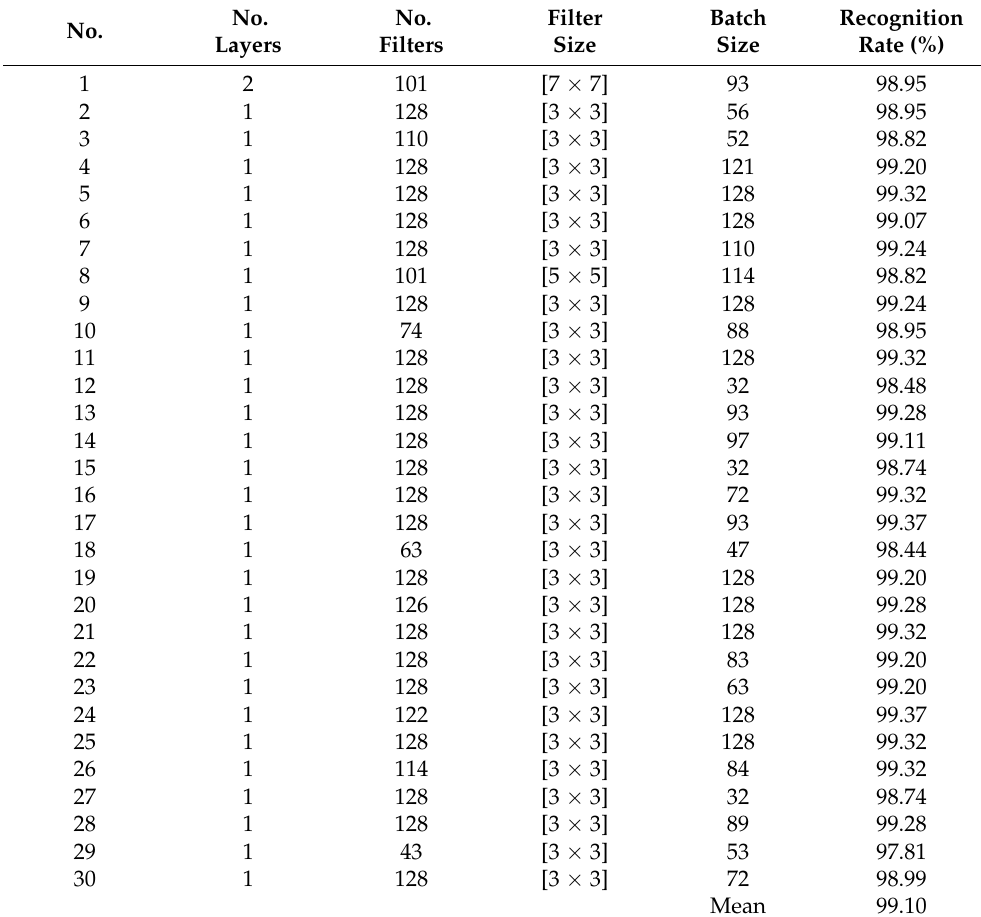
Table 11. Results achieved by the PSO-CNN-I in MSL alphabet